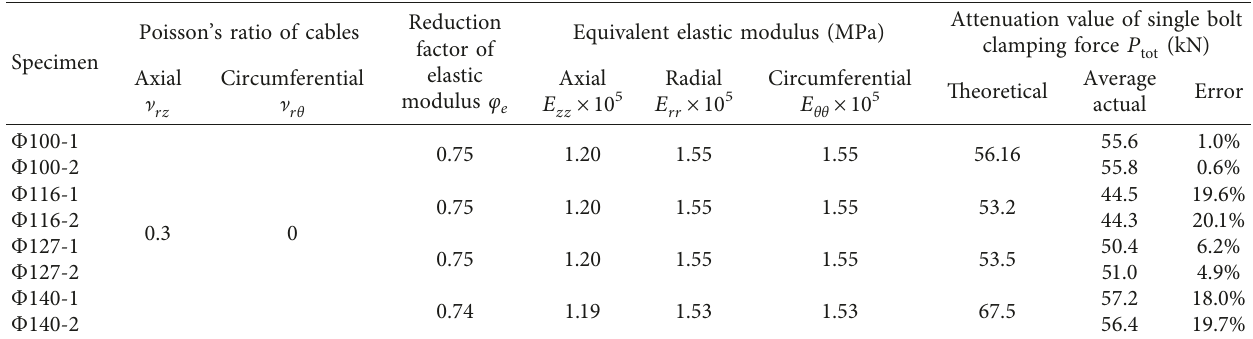
Attenuation value of single bolt clamping force P tot